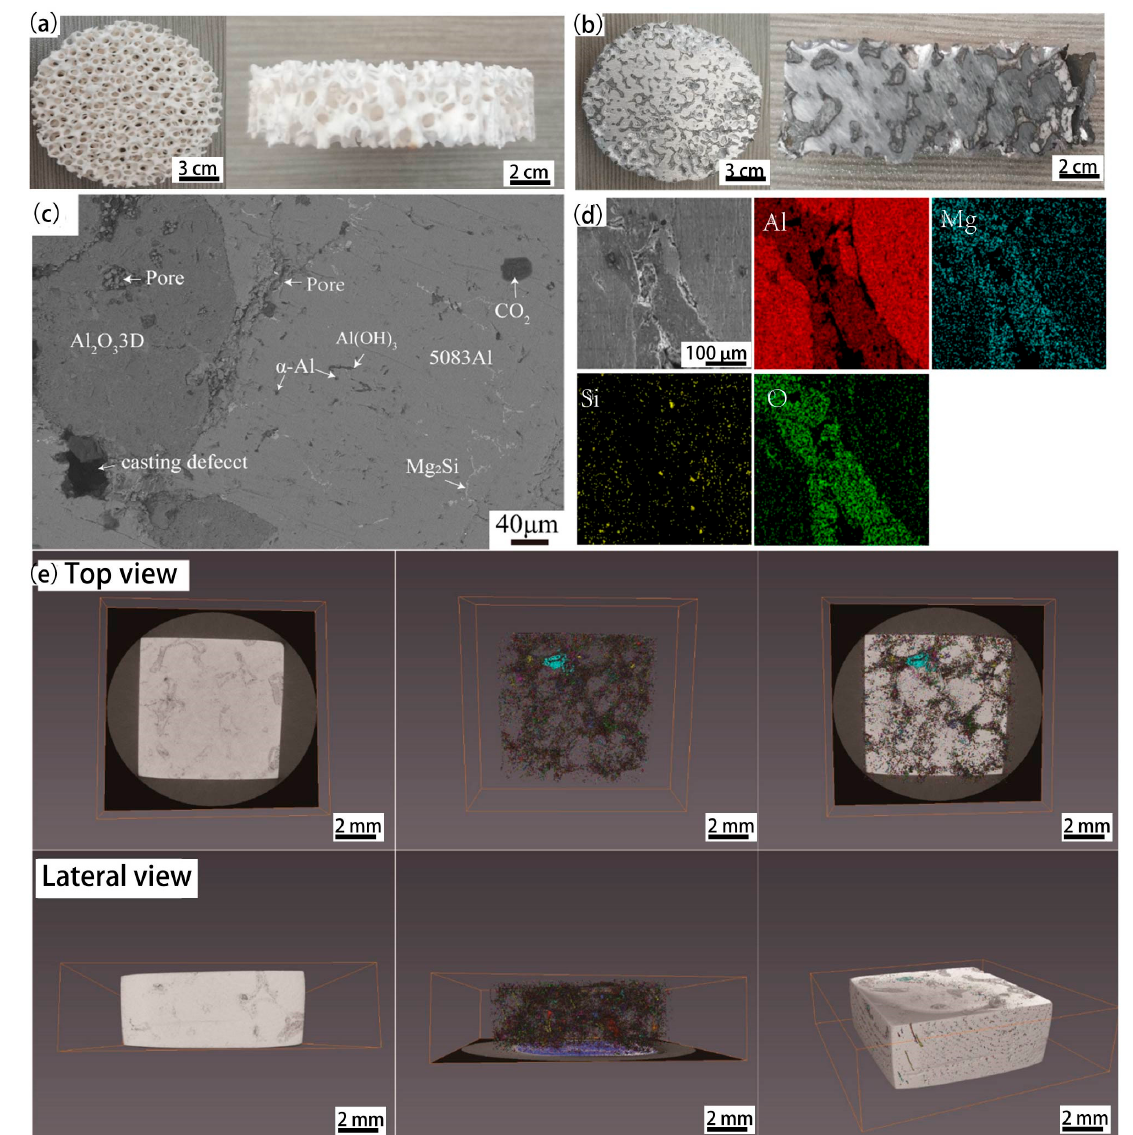
Figure 2. ( a ) Al 2 O 3 3D; ( b ) sampling point of Al 2 O 3 3D/5083Al; ( c ) SEM (Scanning Electron